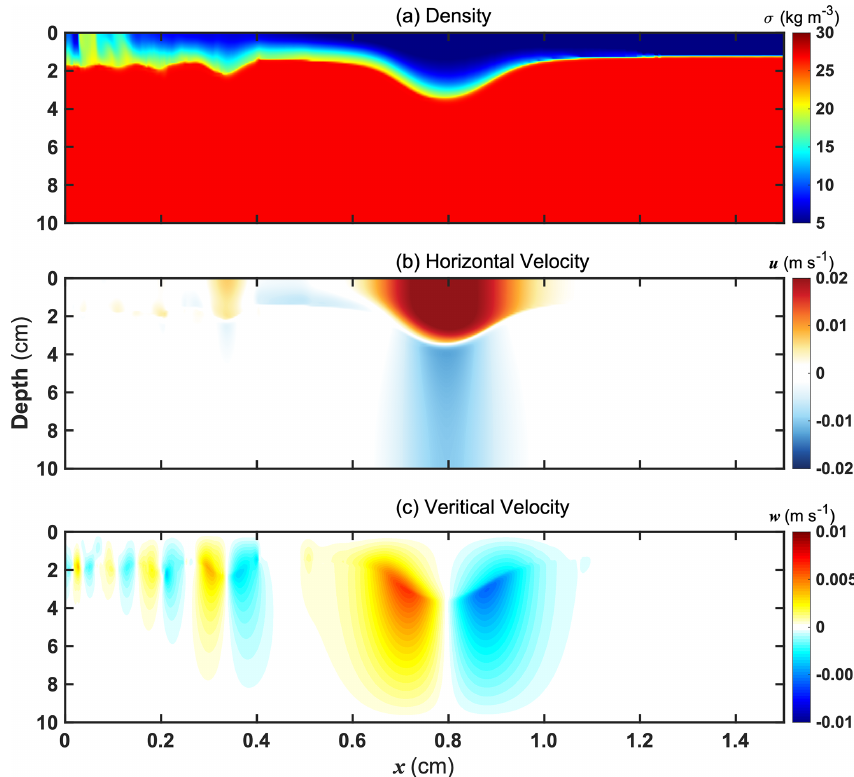
Figure 6. From top to bottom: density as well as the horizontal and vertical velocity fields of the ISWs at t = 24 . 5s.